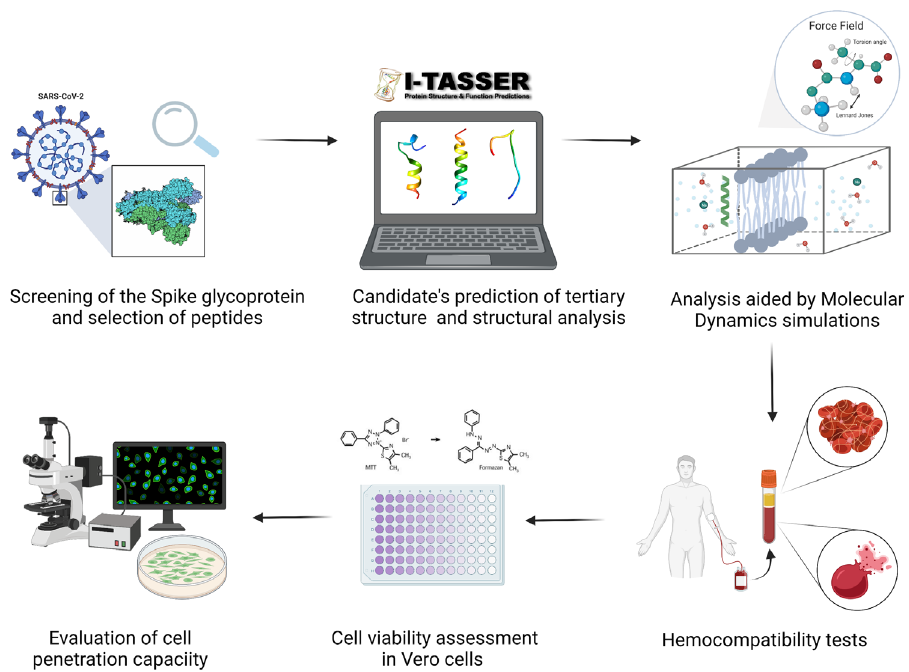
Figure 1. Schematic of the methodology for the rational search of peptides with translocating capacity aided by computational strategies and in vitro testing that included cell internalization and endosome escape, platelet aggregation tendency, hemolytic behavior, and cytotoxicity.